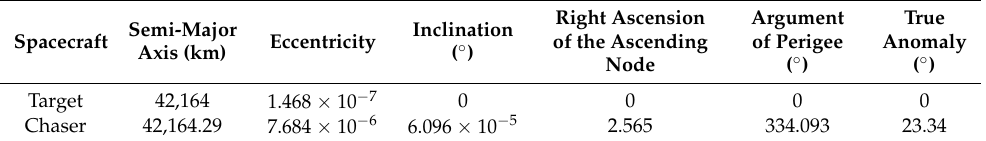
Table 4. Orbital parameters of the target and chaser spacecraft at the beginning of the simulation of the